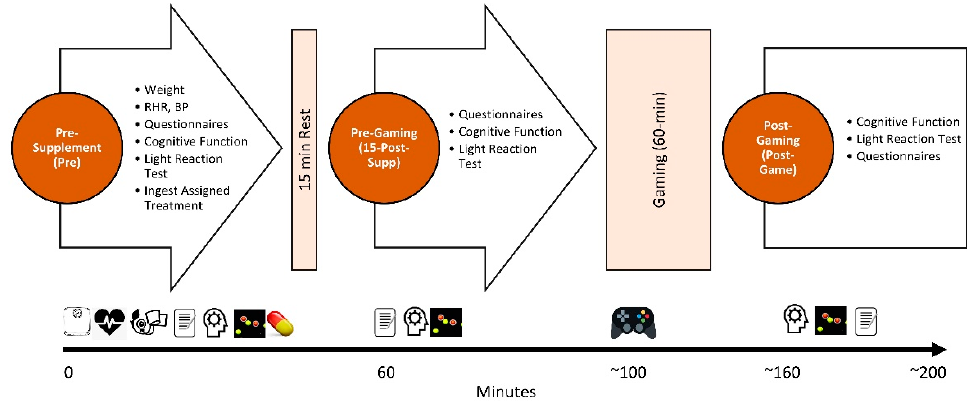
Figure 3. Timeline of testing sessions. RHR represents resting heart rate, while BP represents blood pressure. Questionnaires included the Profile of Mood States, fatigue and eye irritability rating, side effects, and sleep quality. Cognitive function tests included the Berg-Wisconsin Card Sorting, Go/No-Go, Sternberg, and Psychomotor Vigilance Task tests.